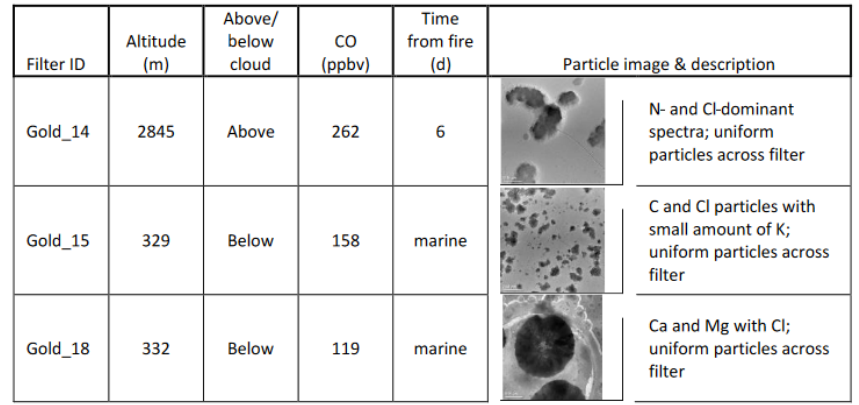
Table 5. Cl-dominant aerosol on CLARIFY